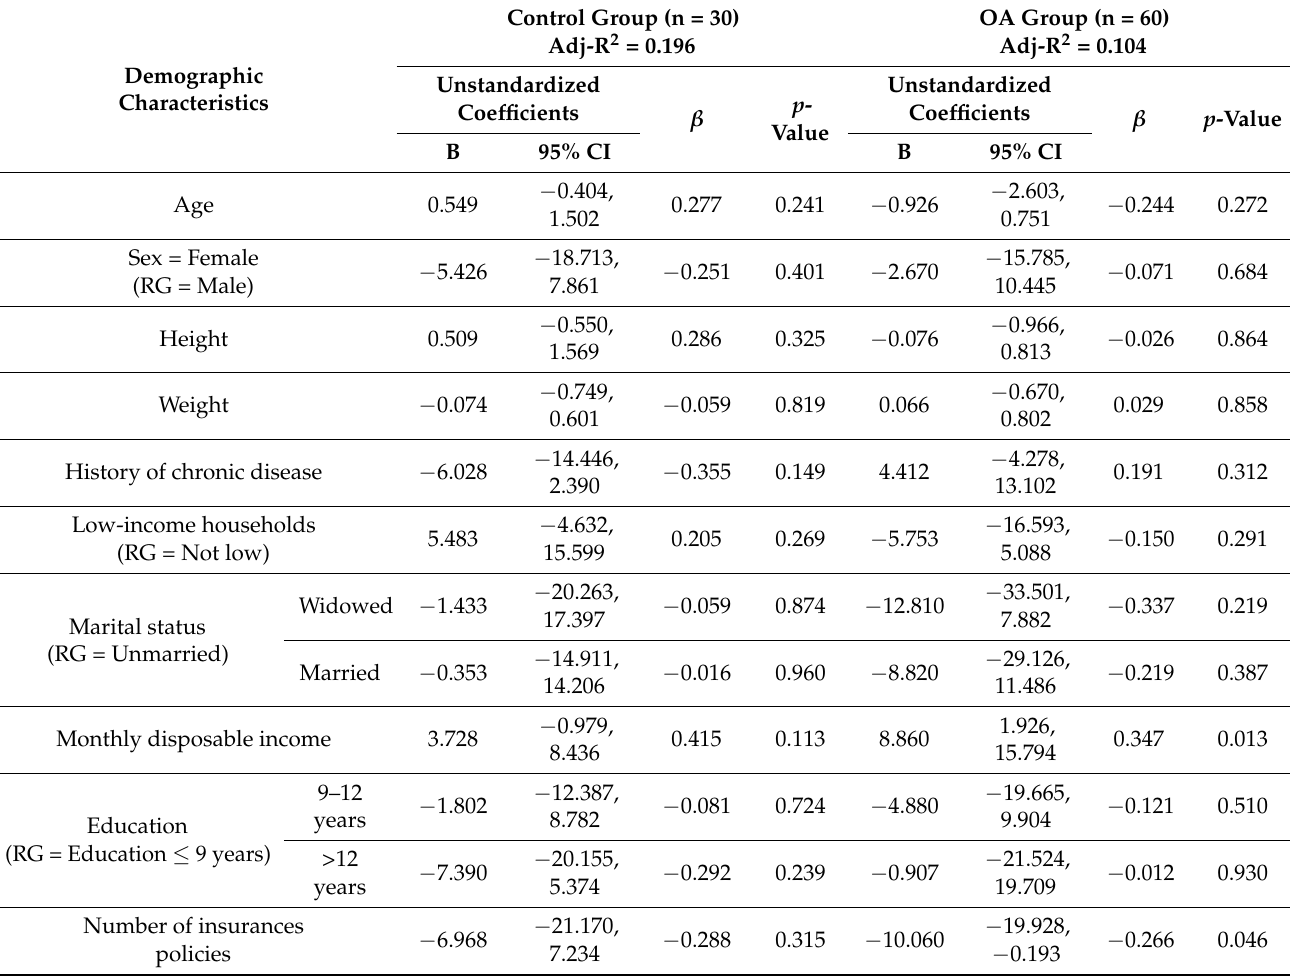
Table 3. Multiple regression analysis between demographic characteristics and SF-36 in control and osteoarthritis groups.